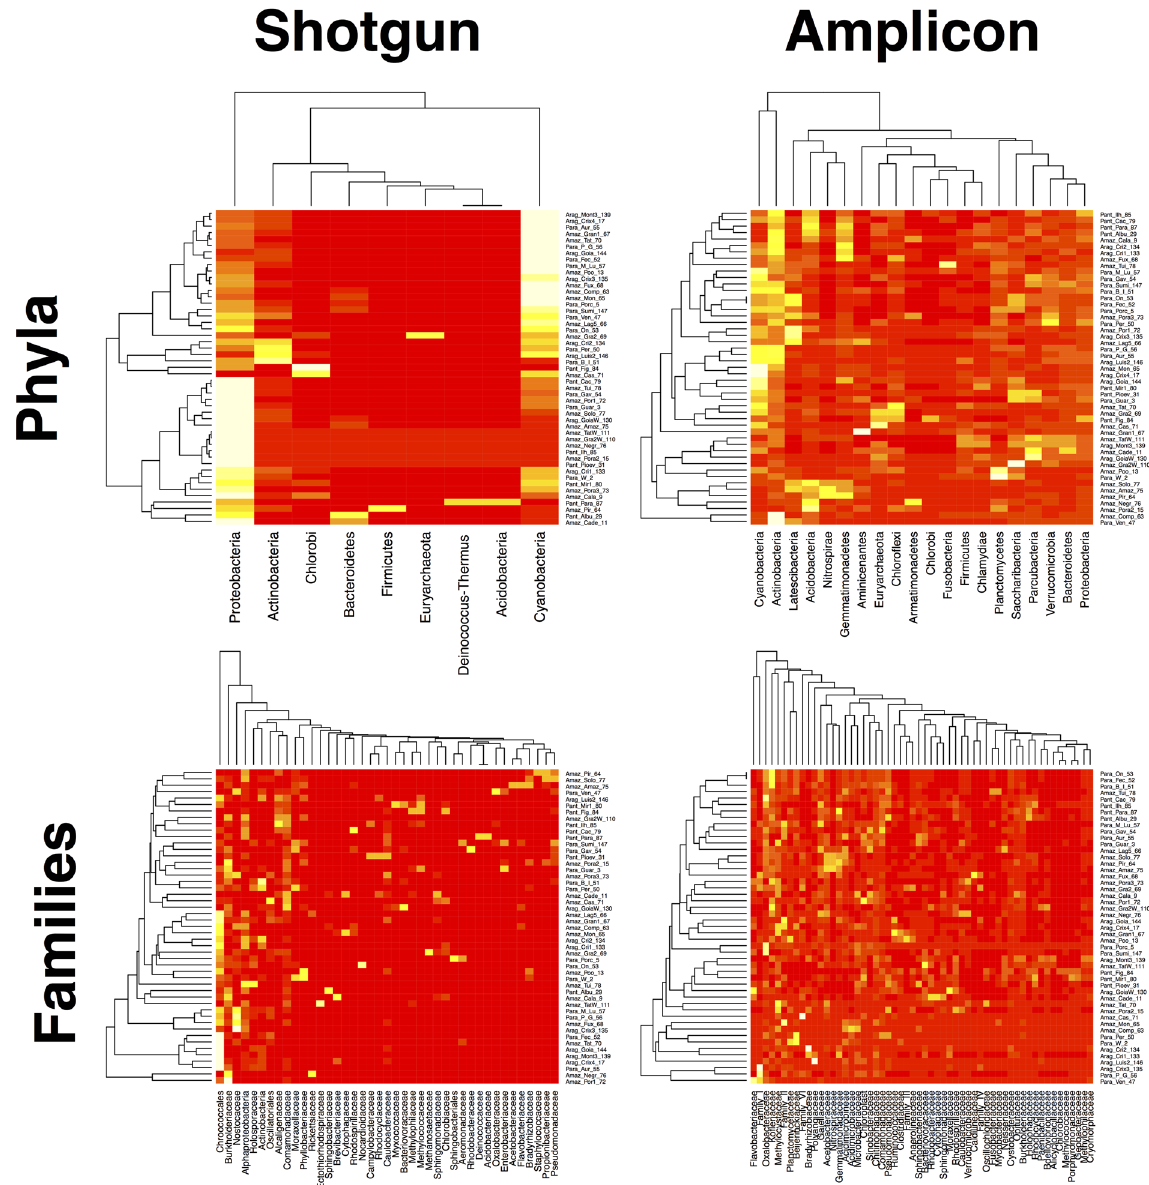
Figure 4. Heatmaps of shotgun vs. amplicon sequencing strategies showing taxon abundance at the phylum and family levels. Please note that data were double standardized for better visualization of low abundance taxa and because this is common for